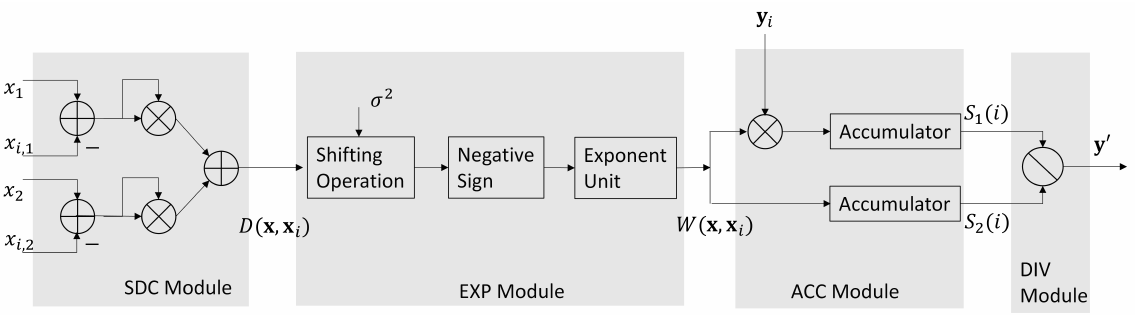
Figure 4. The architectures of the SDC module, EXP module, ACC module and DIV